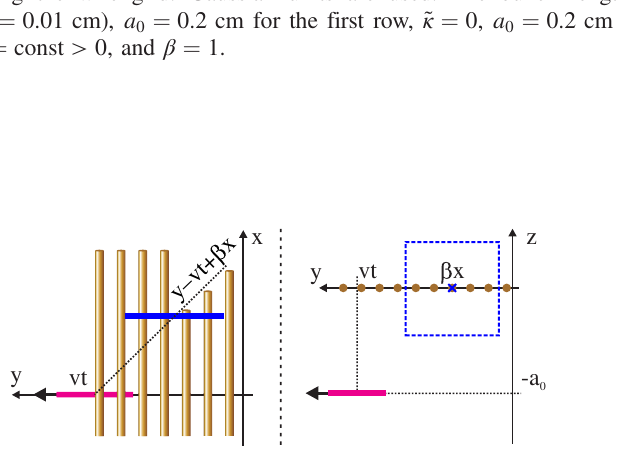
1 cm for the third row; δ ¼ 0 , 0 ¼